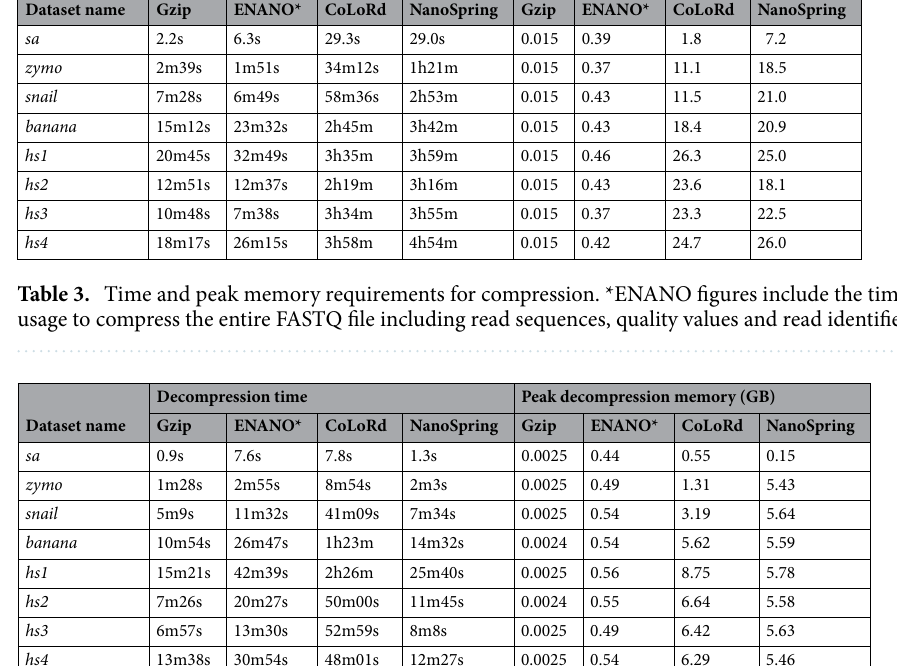
Table 4. Time and peak memory requirements for decompression. *ENANO figures include the time/memory usage to decompress the entire FASTQ file including read sequences, quality values and read identifiers.